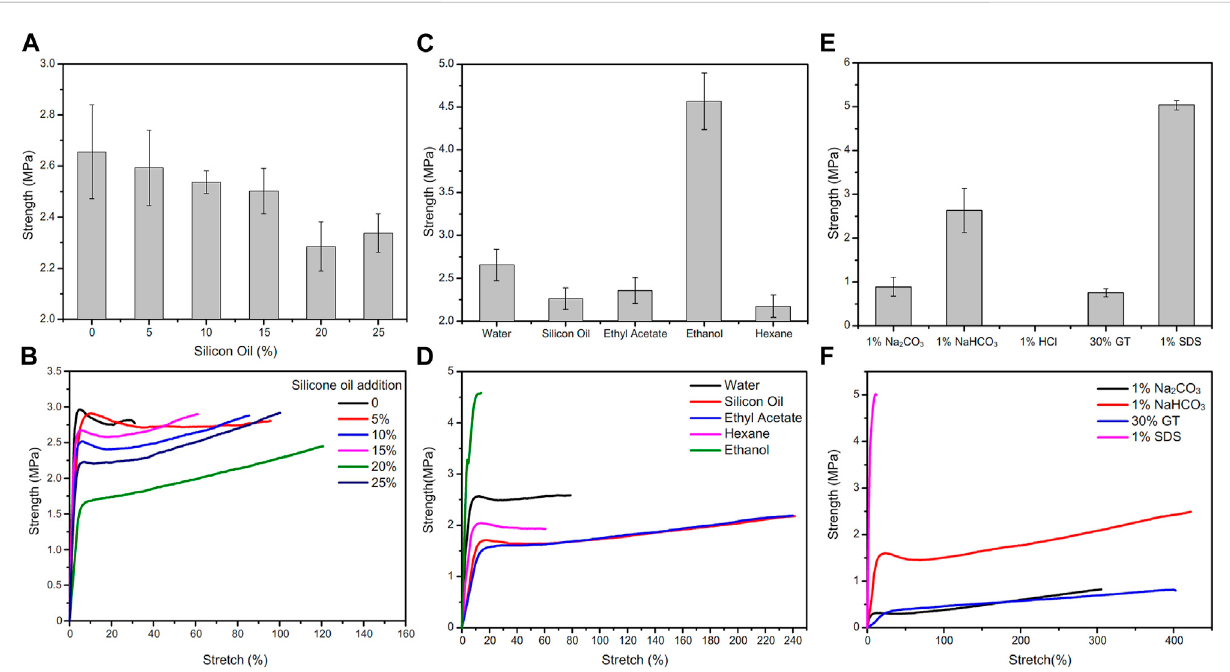
FIGURE 7 ChangeoftensilestrengthofPMAA/PEIgelunderdifferentconditions. (A) AddingsiliconeoilofdifferentcontenttoPMAA/PEIgel,thestrengthofgel slightlydecreasedwiththeincreaseofsiliconeoilcontent; (B) Forthetensileforcecurveofgelwithdifferentsiliconeoilcontent,thebreakingelongation ofgelincreaseswiththeincreaseofsiliconeoilcontent; (C) Thetensilestrengthofgelsoakedinwaterandseveralorganicsolventsfor24 h; (D) Gelforce curve after immersion in water and several organic solvents. The elongation at break of gel soaked in ethyl acetate and silicone oil increased a lot, while the modulus of gel soaked in ethanol increased a lot; (E) Tensile strength of PMAA/PEI gel soaked in several solutions; (F) The tensile force curve of gel soaked in several